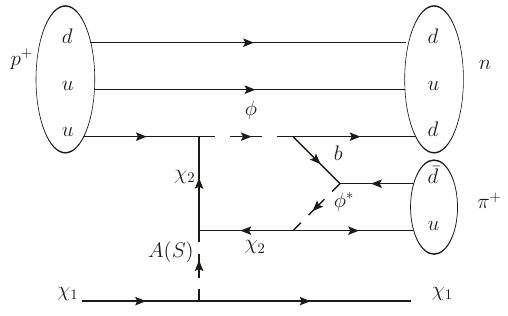
Figure 11 . Example of exotic nucleon conversion arising in dark sector